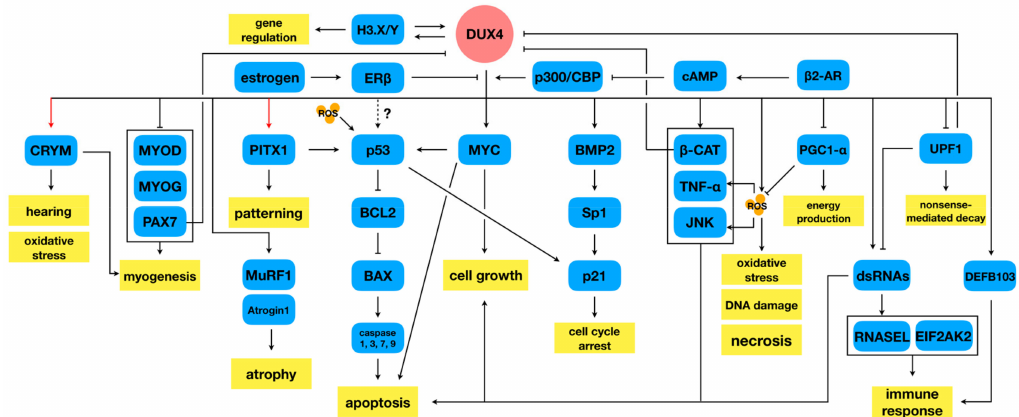
Figure 1. DUX4 signalling in FSHD-a ff ected skeletal muscle. A simplified overview of the various signalling activities of DUX4 discussed in this review is depicted. Red arrows indicate a confirmed direct downstream DUX4 transcriptional target. Abbreviation: ROS, reactive oxygen species; FSHD facioscapulohumeral muscular dystrophy; DUX4: double homeobox protein